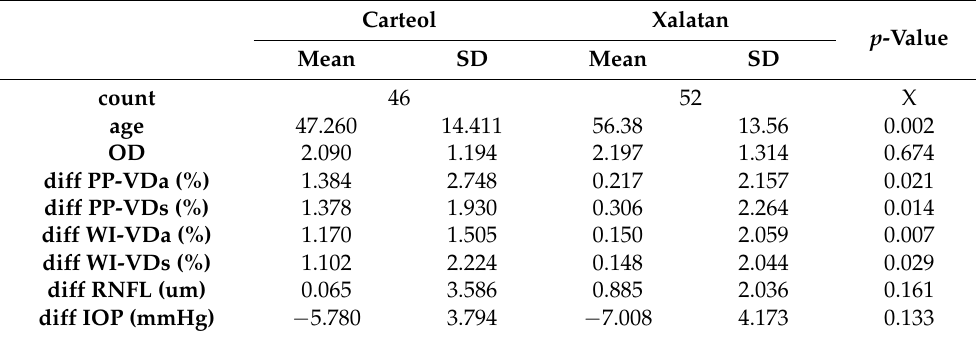
Table 1. Summary data of analysis.